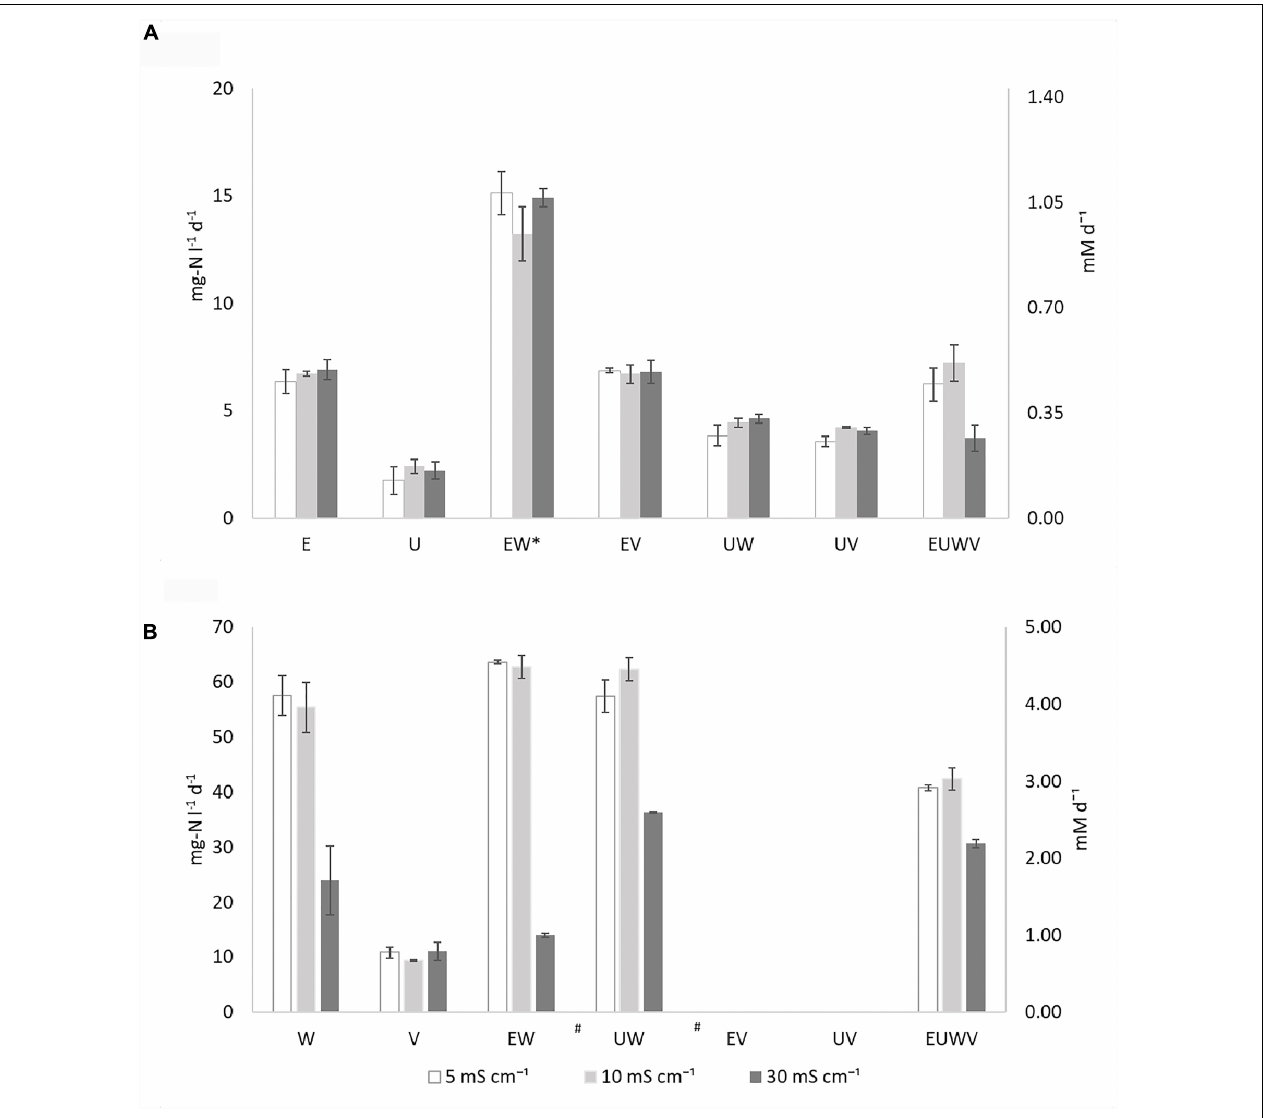
FIGURE 1 | Overview of the ammonia oxidation rates (A) and nitrite oxidation rates (B) expressed as mg-N l − 1 d − 1 and mM d − 1 (secondary axis) at different salinities (EC: 5, 10, and 30 mS cm − 1 ) for the individual strains N. europaea (E), N. ureae (U), N. winogradskyi (W), N. vulgaris (V) and synthetic communities combining N. europaea and N. winogradskyi (EW) , N. ureae and N. winogradskyi (UW), N. europaea and N. vulgaris (EV), N. ureae and N. vulgaris (EV), N. europaea, N. ureae, N. winogradskyi, and N. vulgaris (EUWV) ( n = 3) at OD 600 of 0.1. The communities marked with ( ∗ ) present an activity which is significantly different than the others ( p < 0.05), while the communities marked with ( # ) present a significant difference at 30 mS cm − 1 ( p <